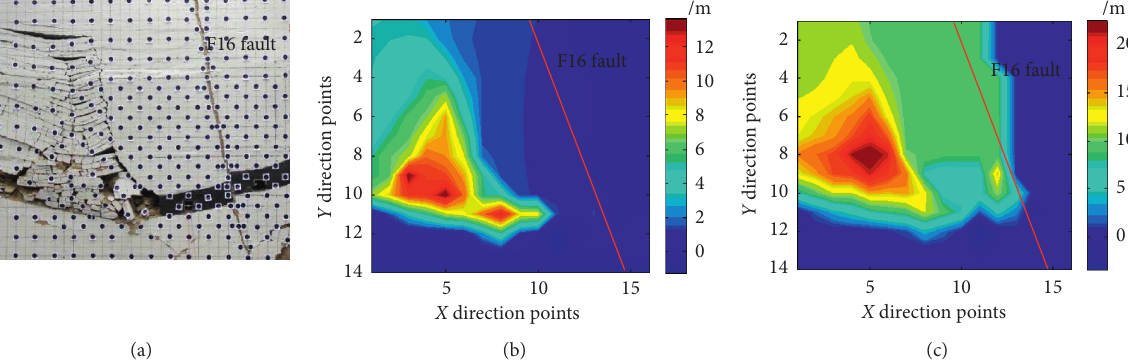
Figure 13: Comparison of displacement changes before and after fault slip. (a) Similar simulation model, (b) before fault slip, and (c) after fault slip.